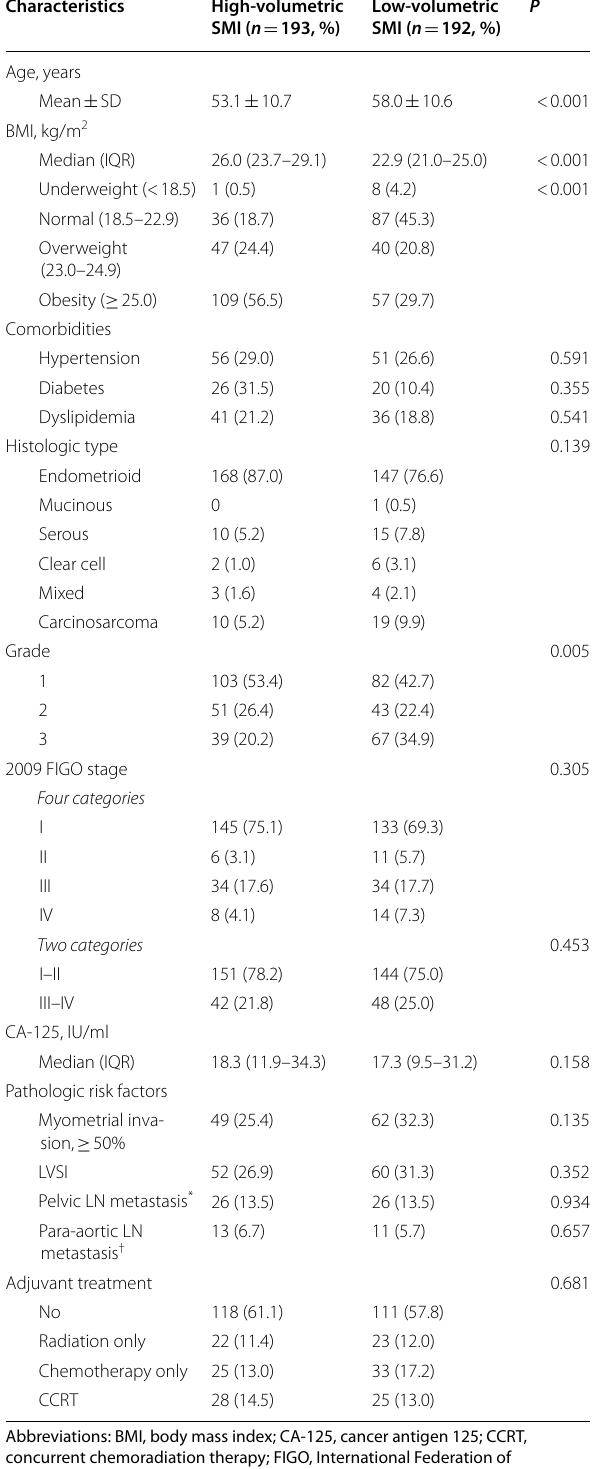
Table 2 Clinicopathologic characteristics of high‑ and low‑ volumetric SMI